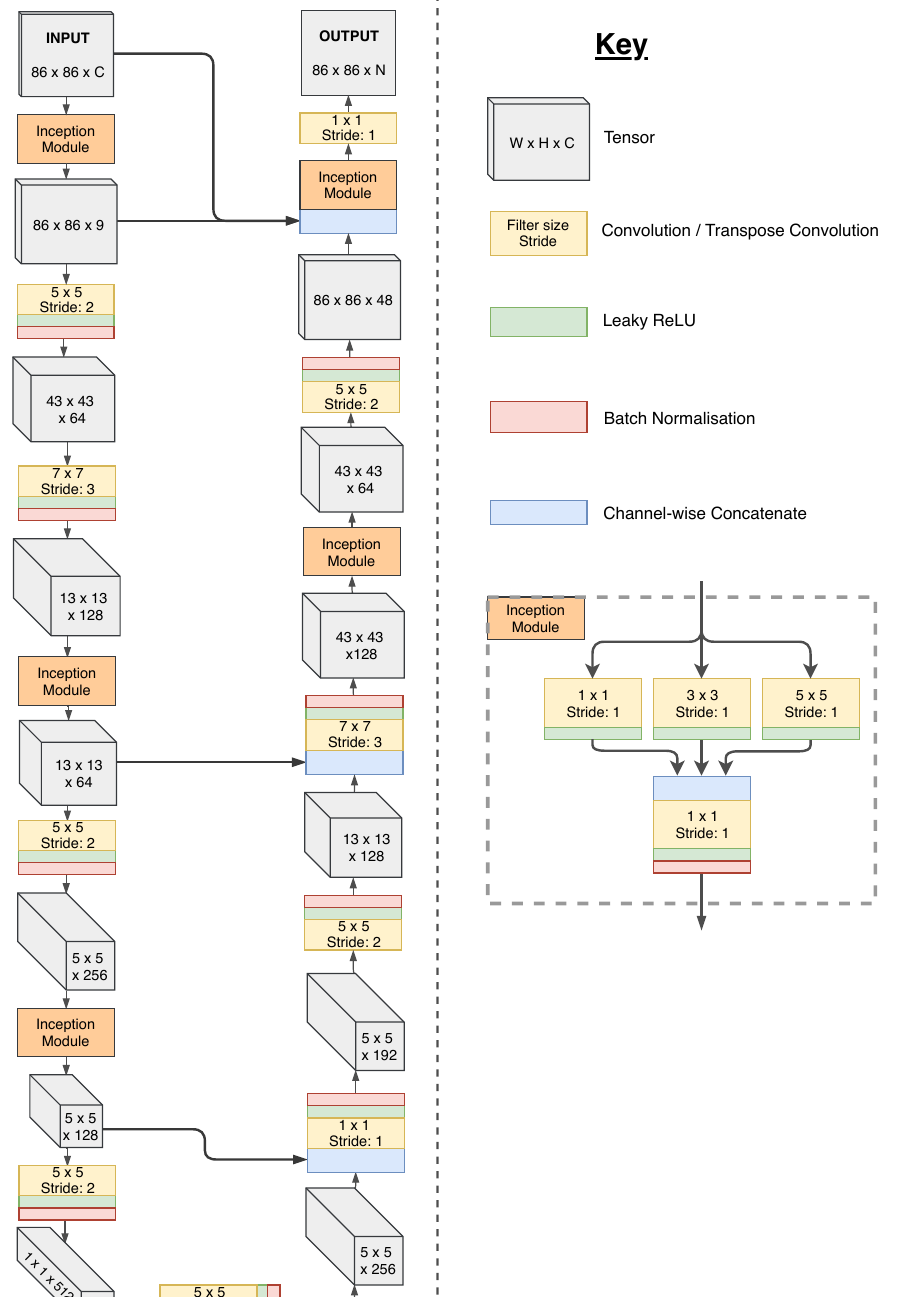
Figure 1. Flowchart of CNN used in cloud segmentation. Bold arrows represent residual connections, connecting different stages of the encoder and decoder arms of the model which run in a U shape. ‘Inception module’ denotes a set of parallel convolutions of stride 1, followed by a single dimensionality-reduction convolution on their concatenated outputs. Widths and heights of inputs and outputs are the minimum and could be any integer multiple of 24 above 86, with internal tensor dimensions changing accordingly. The first input layer is given C channels, as a placeholder for whatever kind of input being used (e.g., 3 for RGB). The output has channel depth N, to denote the number of output classes